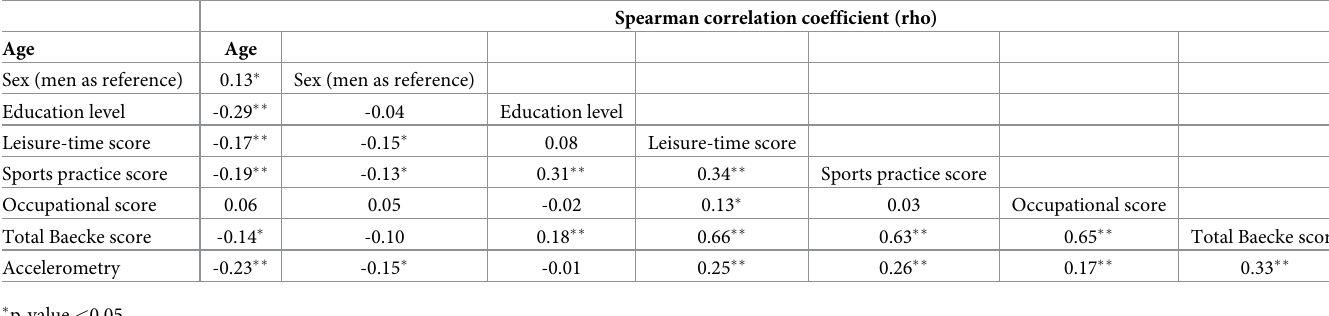
Table 2. Correlation matrix between variables (n = 251).